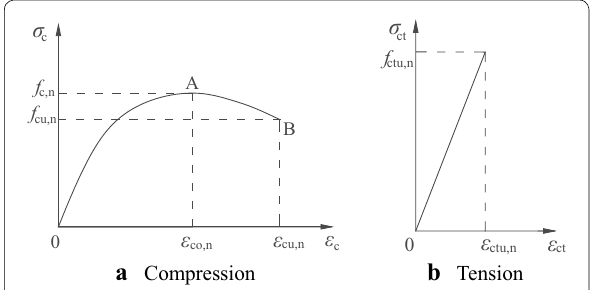
Fig. 10 Constitutive relationships of